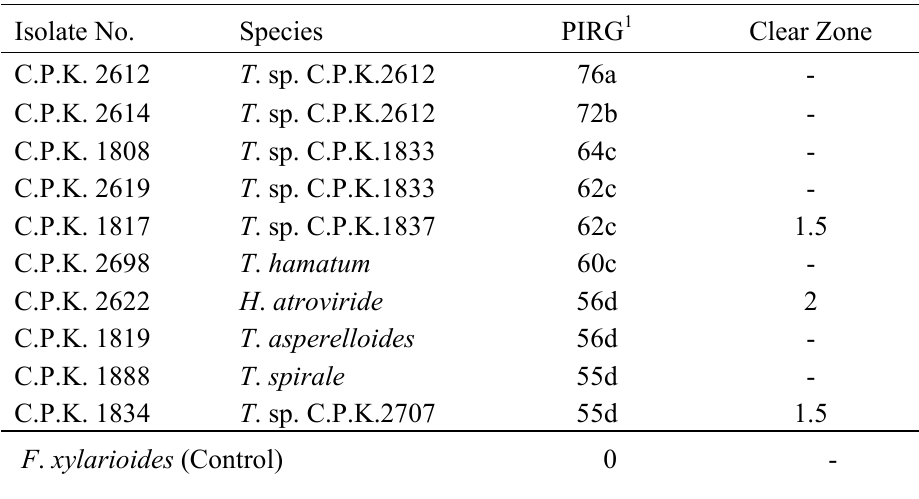
Table 3. Ability of selected Trichoderma strains isolated from rhizosphere of C . arabica to inhibit G .